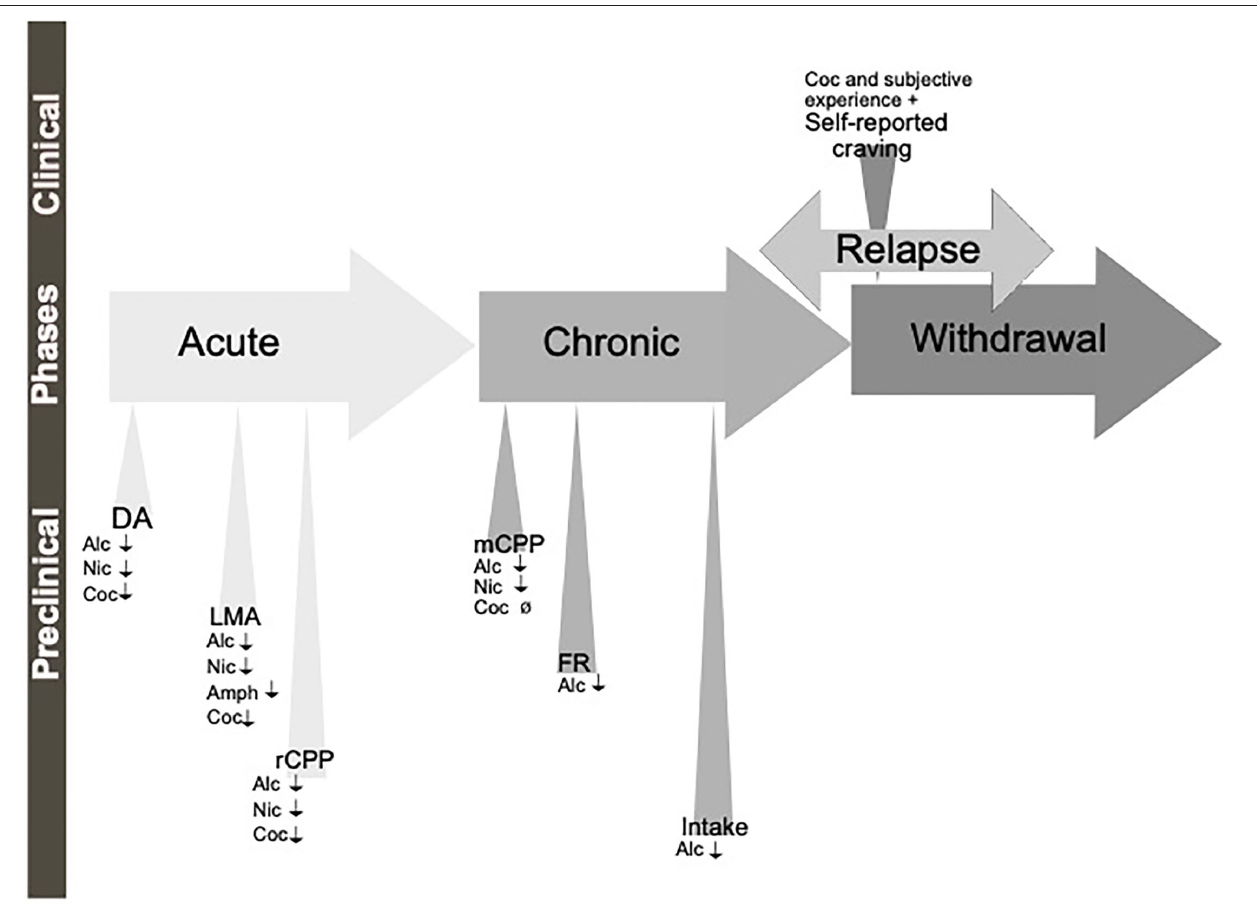
FIGURE 5 | Schematic illustration of the different phases of the addiction cycle which amylin signaling influence. Amylin or amylin receptor agonists influence behaviors of the addiction cycle, related to alcohol (Alc), nicotine (Nic), Amphetamine (Amph) or cocaine (Coc). Positive association ( + ), decreases/attenuates ( ↓ ), conflicting evidence or no effect (Ø) on drug effect. Dopamine release in nucleus accumbens (DA), locomotor stimulation (LMA), reward of conditioned place preference (rCPP), memory of alcohol reward in the CPP test (mCPP), motivation (FR, and PR), Alcohol and drug intake (Intake), functional magnetic resonance